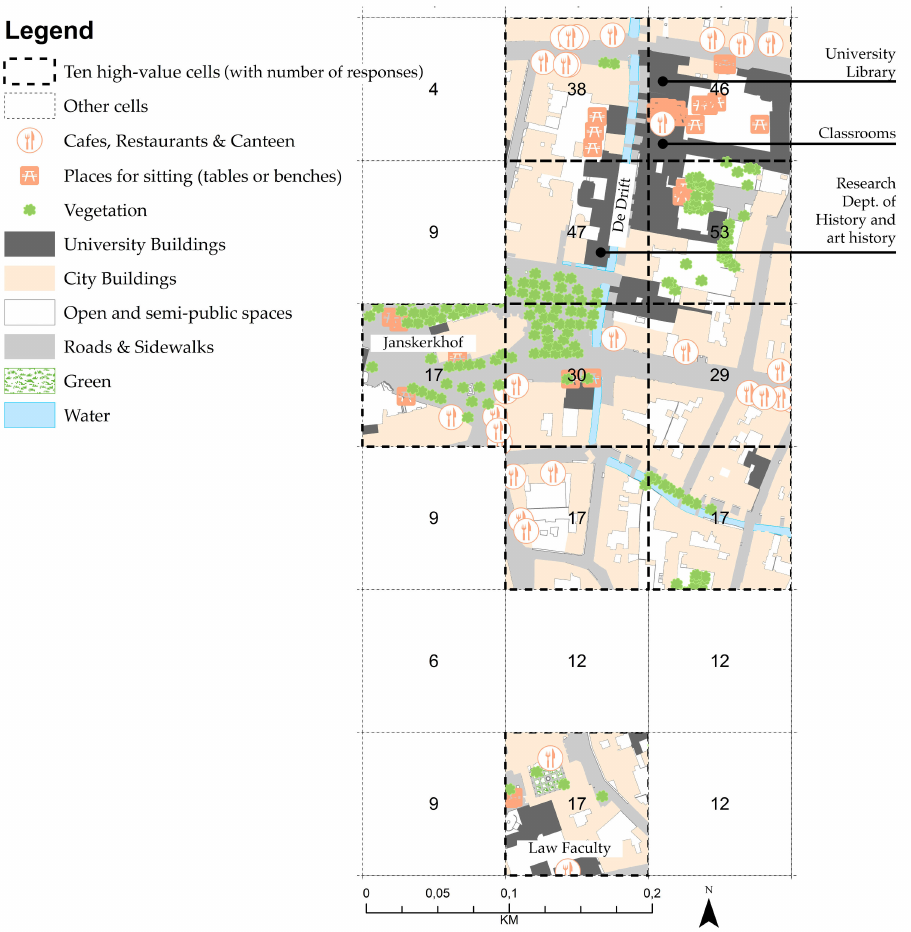
Figure 13. Ten high-value cells at Utrecht University (UU) inner-city